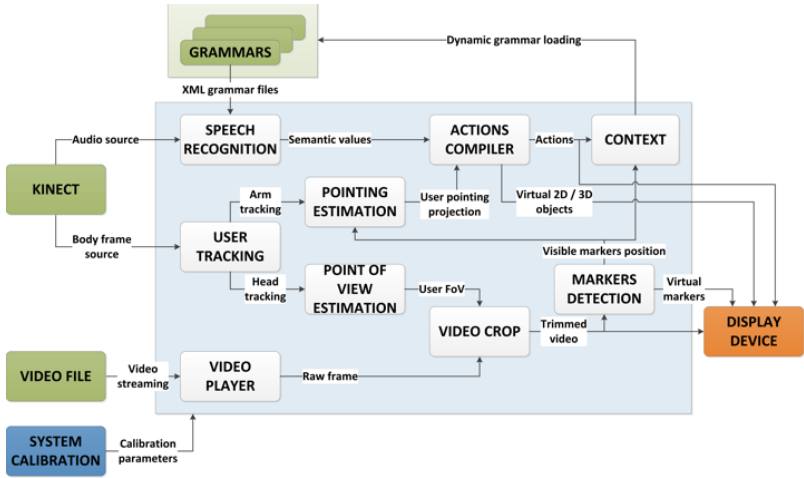
Figure 2. System